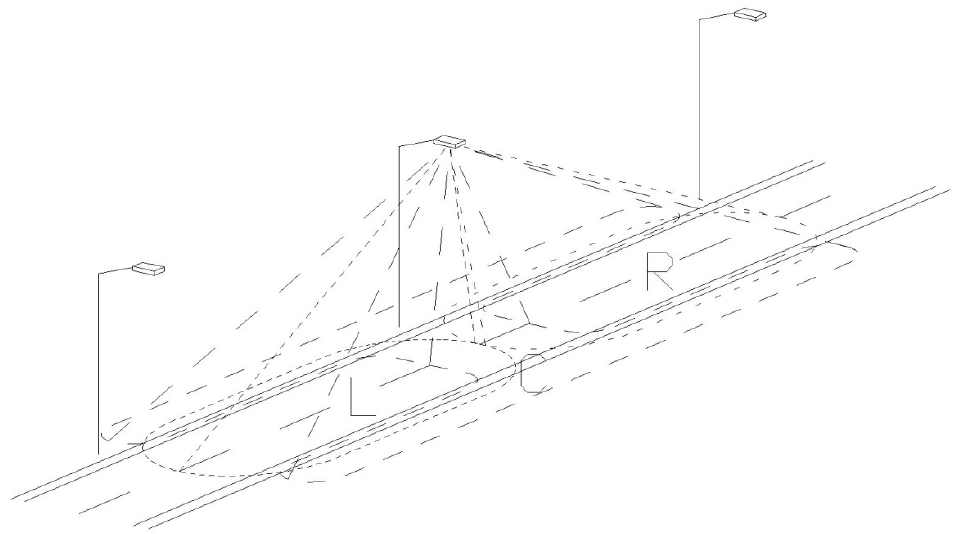
Figure 4. Areas of the road surface illuminated by the individual luminaire